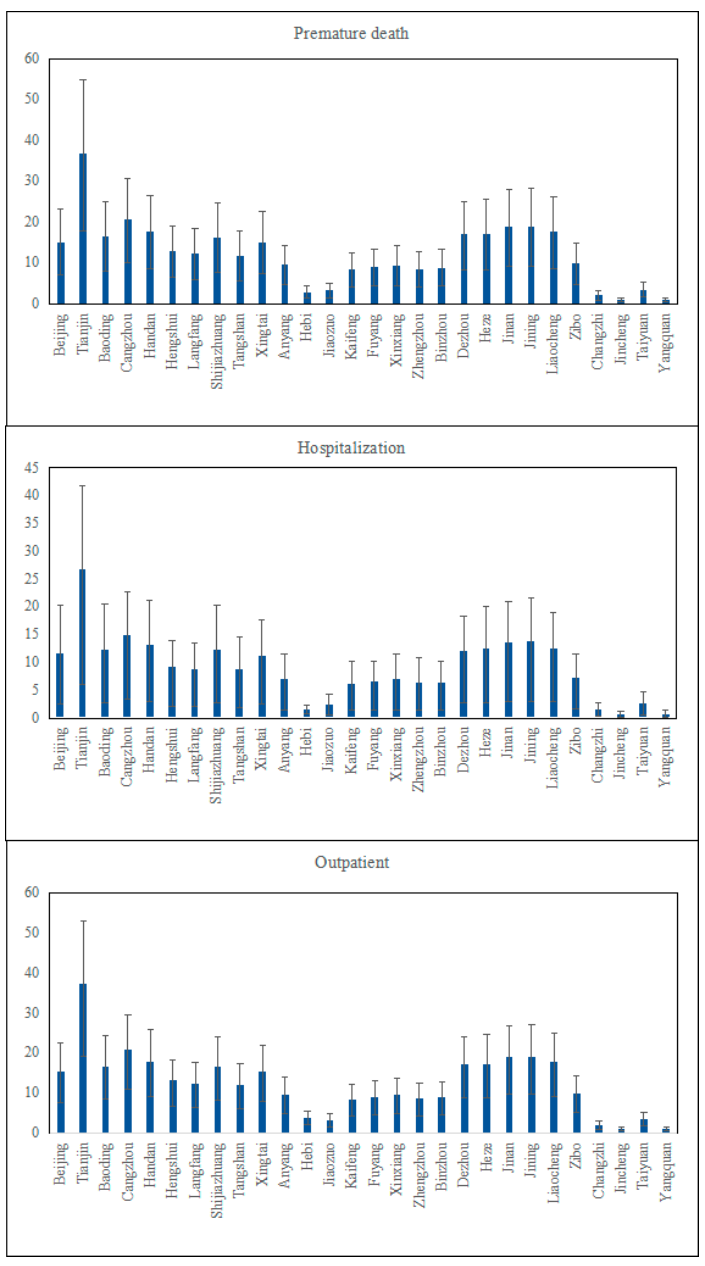
Figure 4. ‘2 + 26’ urban public health effect terminal loss values (ten thousand cases).